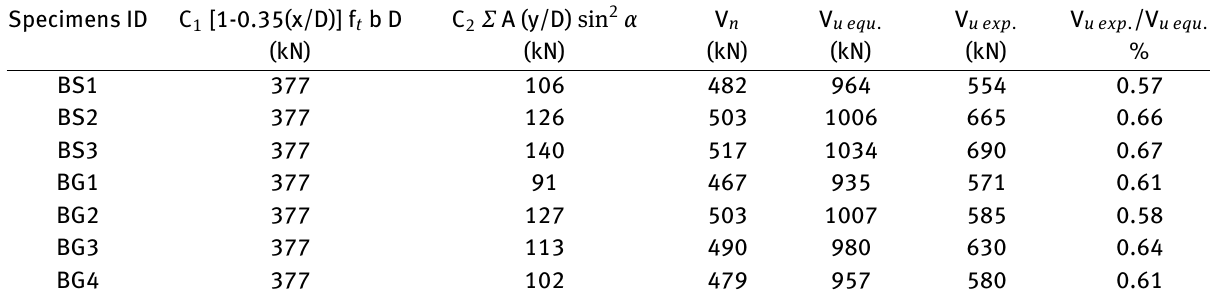
Table 7: Measured and computed ultimate load deep beams Specimens ID